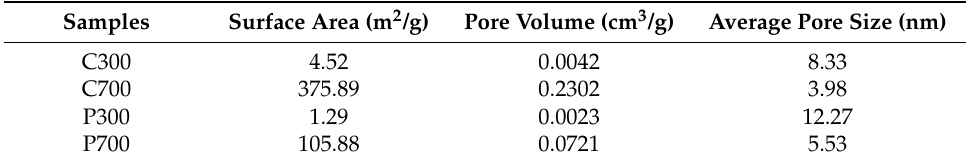
Table 1. BET-N 2 surface area, pore volume, and average pore size of biochars.